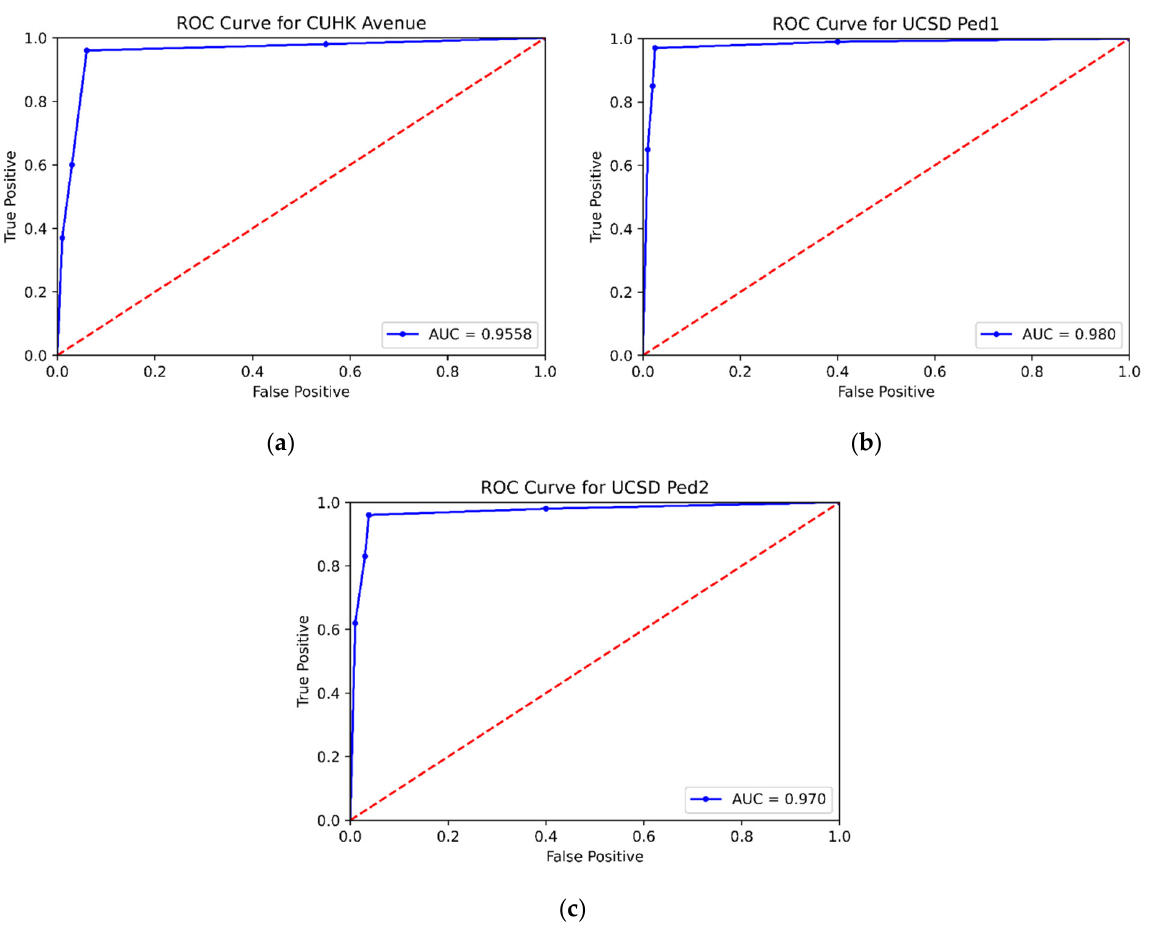
Figure 7. ROC Curves for ( a ) CUHK Avenue, ( b ) UCSD Ped-1, and ( c ) UCSD Ped-2. Table 2. Comparison of proposed method with baseline techniques based on AUC.